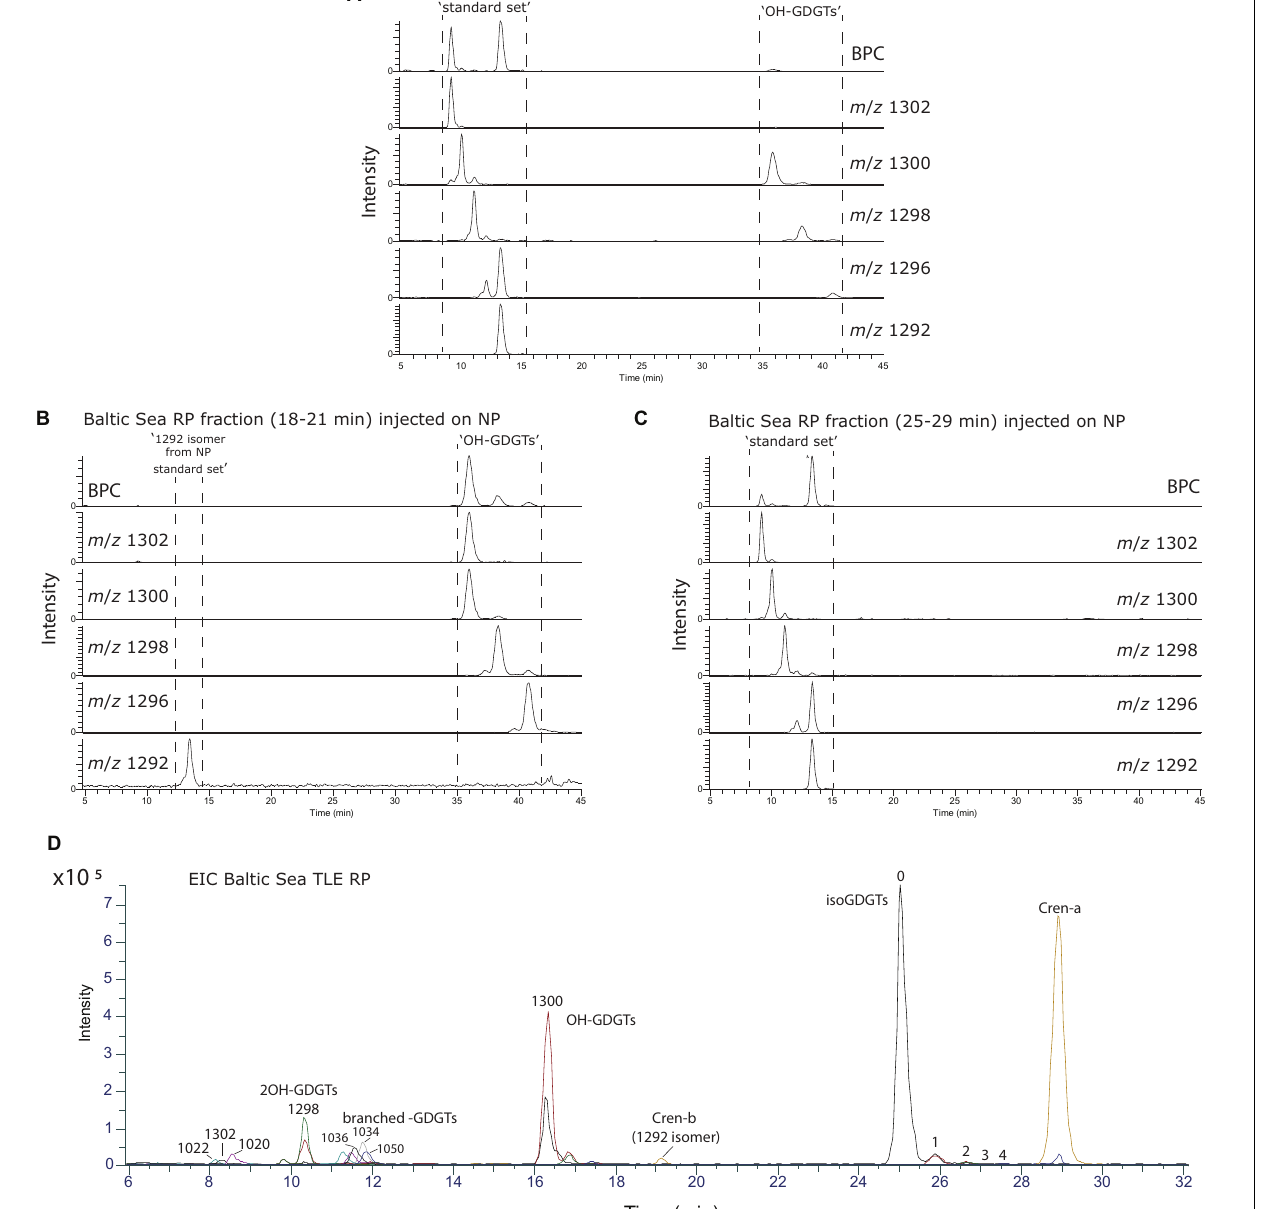
FIGURE 4 | GDGT analyses of a Baltic Sea sediment lipid extract. (A) Polar fraction separated using the traditional NP method using a Cyano column. (B) The 18–21 min fraction from fraction collection after separation the C18-XB method, again using the Cyano NP method. (C) Same as b, but for the 25–29 min fraction. (D) Extracted ion chromatogram overview of isoprenoid and branched GDGT isomers both identified and tentatively identified (based on comparison with other RP methods (Zhu et al., 2013; Liu et al., 2019). The various ion chromatograms are overlaid over each other with different colors.